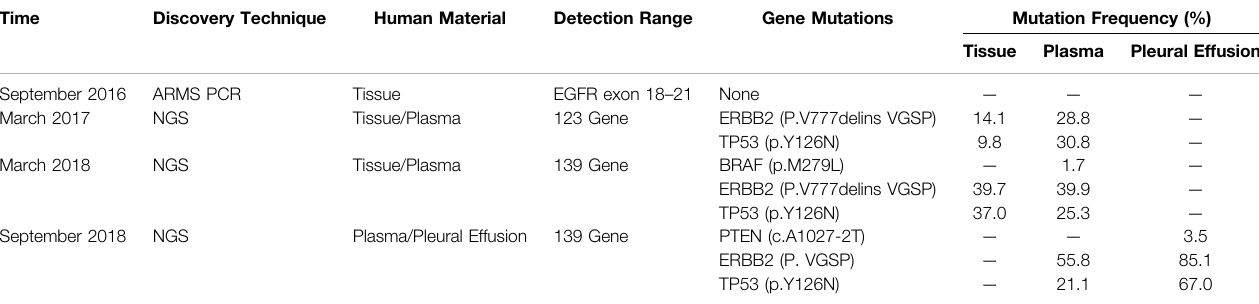
TABLE 1 | List of four gene test results during the whole treatment of patient.